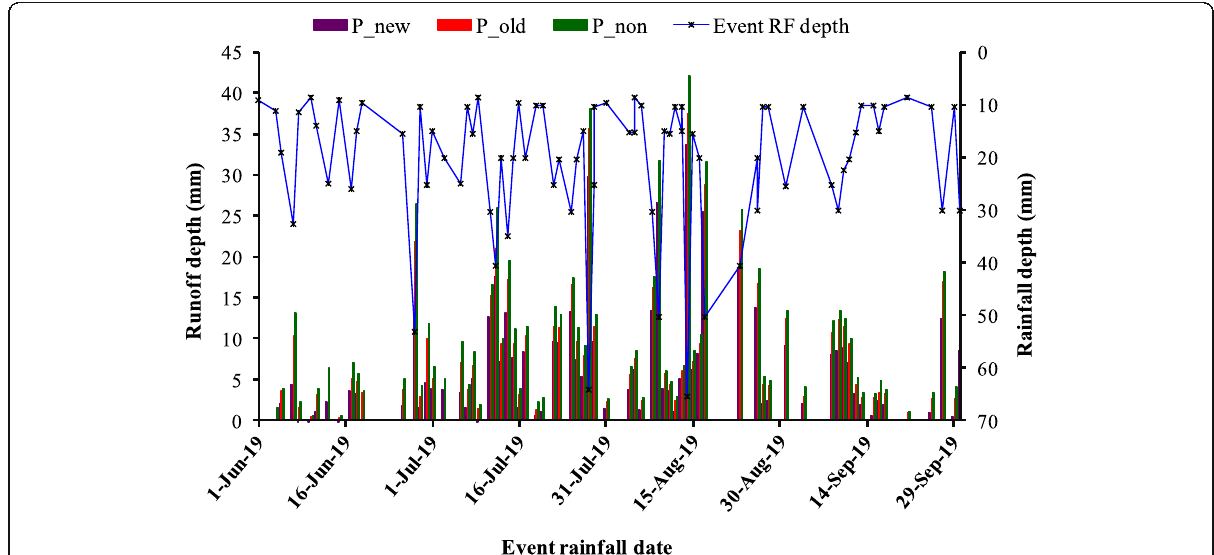
Fig. 4 Event-based rainfall depth (RF, in millimeters) and observed runoff depth (in millimeters) in plots treated with new- and old-graded soil bund and non-treated